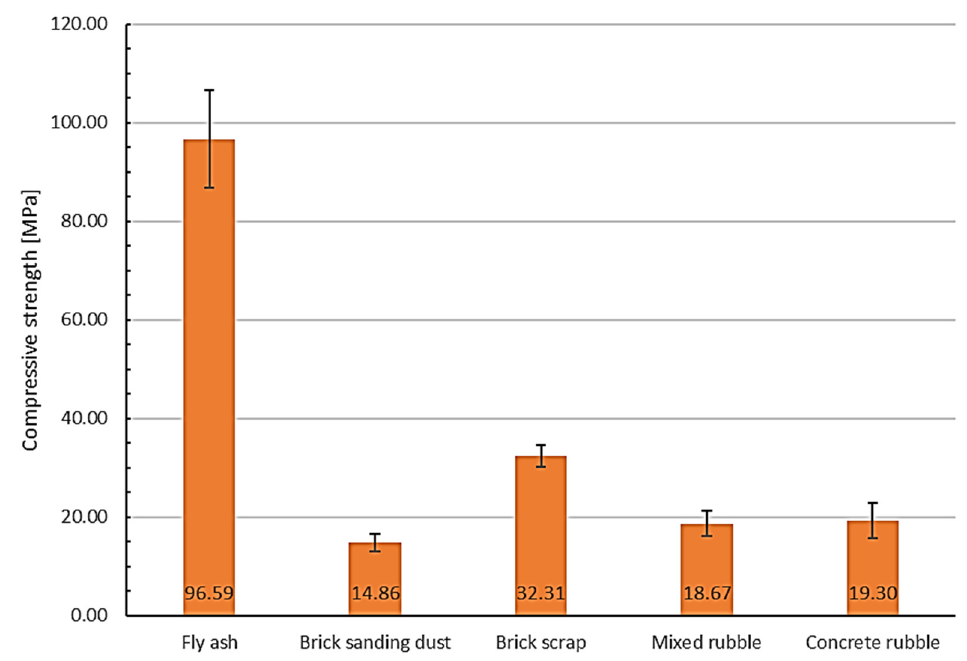
Figure 6. Mean values of compressive strengths of geopolymer stones produced from residual materials with associated standard deviations.